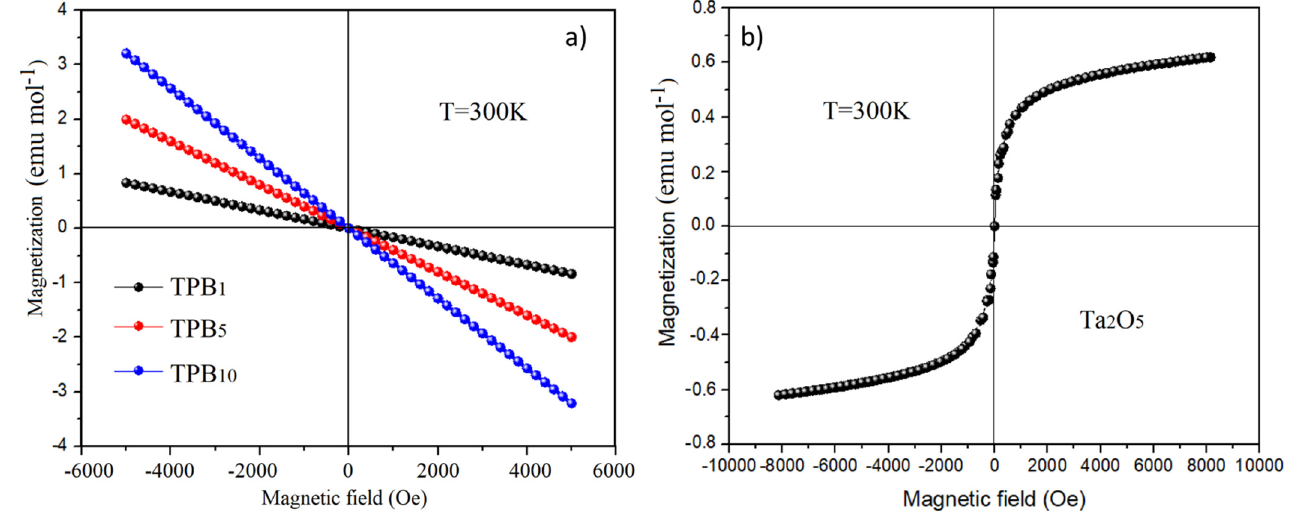
Figure 11. M-H loop of nanocrystals Ta 2 O 5 ( a ) and Ta 2 O 5 -doped glasses ( b ) at room temperature.